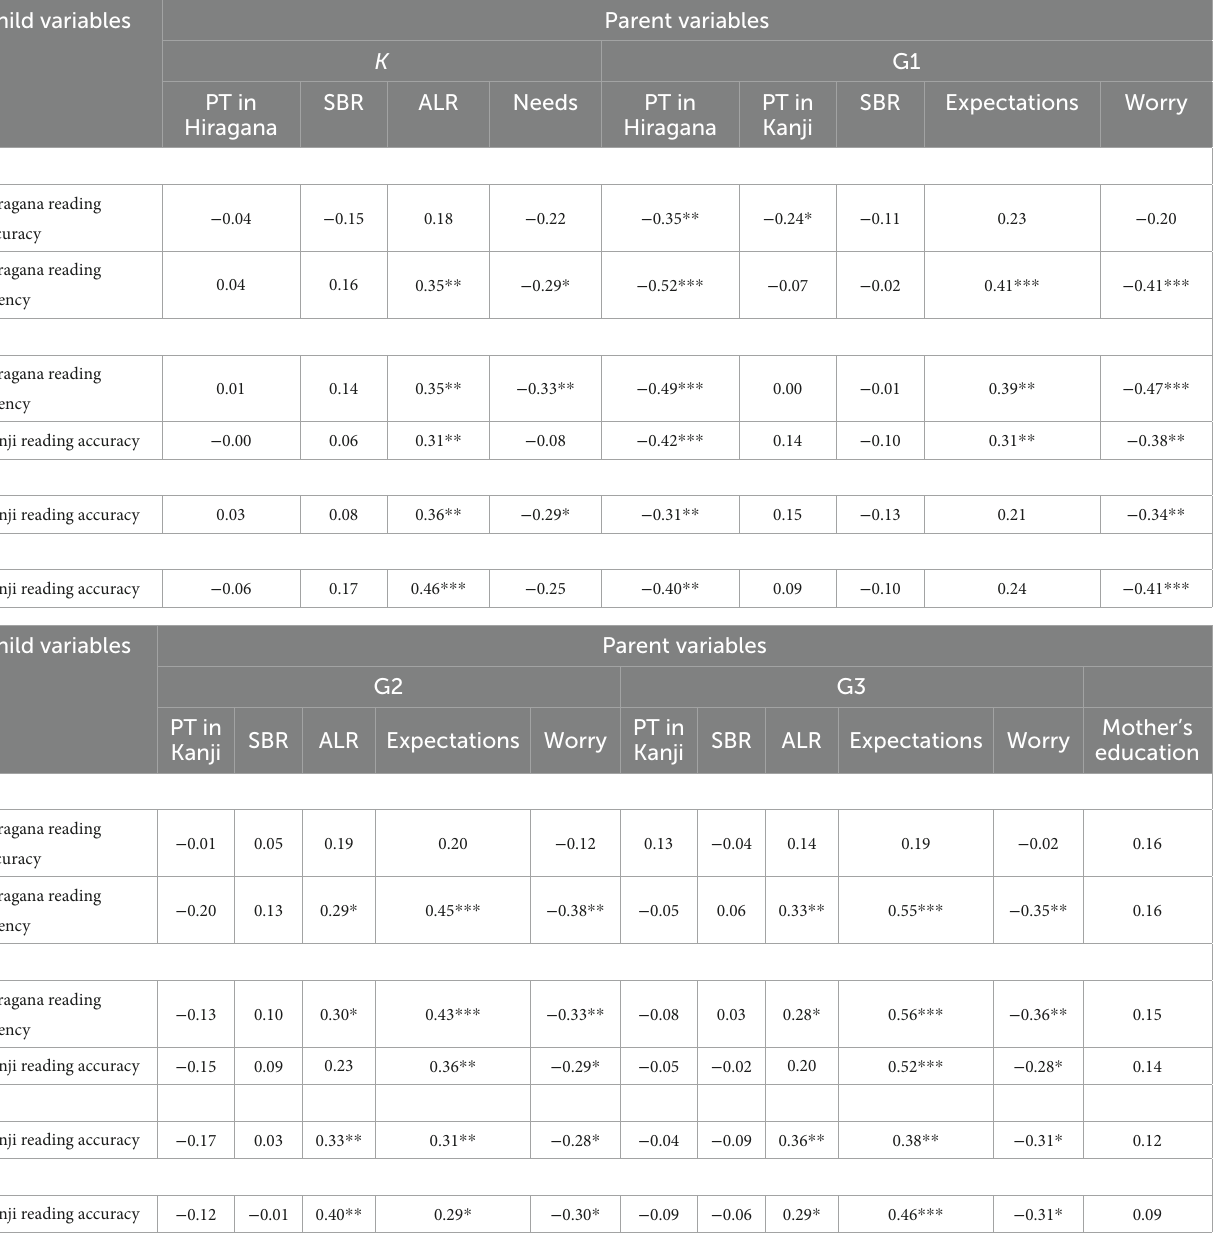
TABLE 3 Correlation between child and parent variables. Child